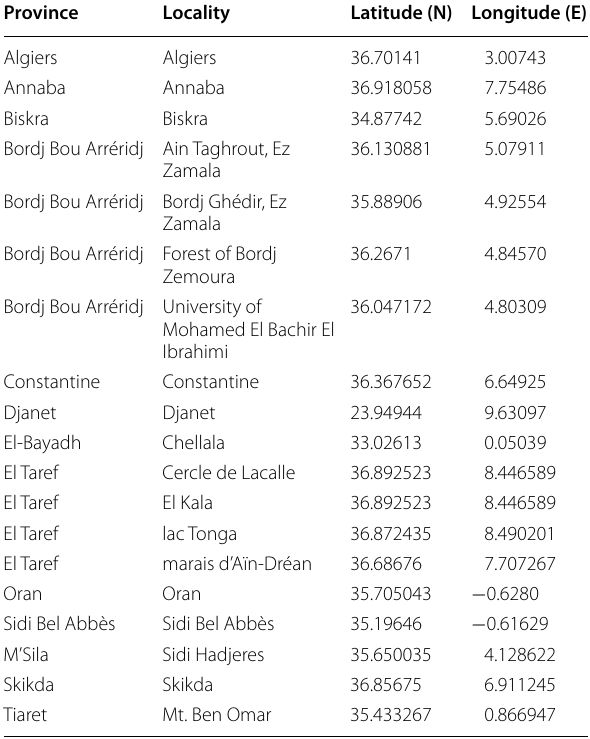
Table 2 A gazetteer of Algerian localities of the